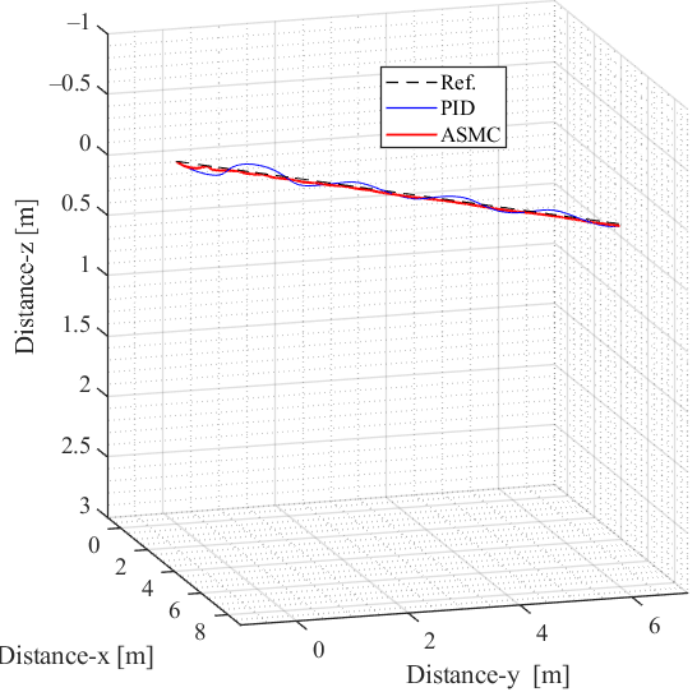
Figure 11. Motion performance of the ROV-glider system in the retrieving stage.